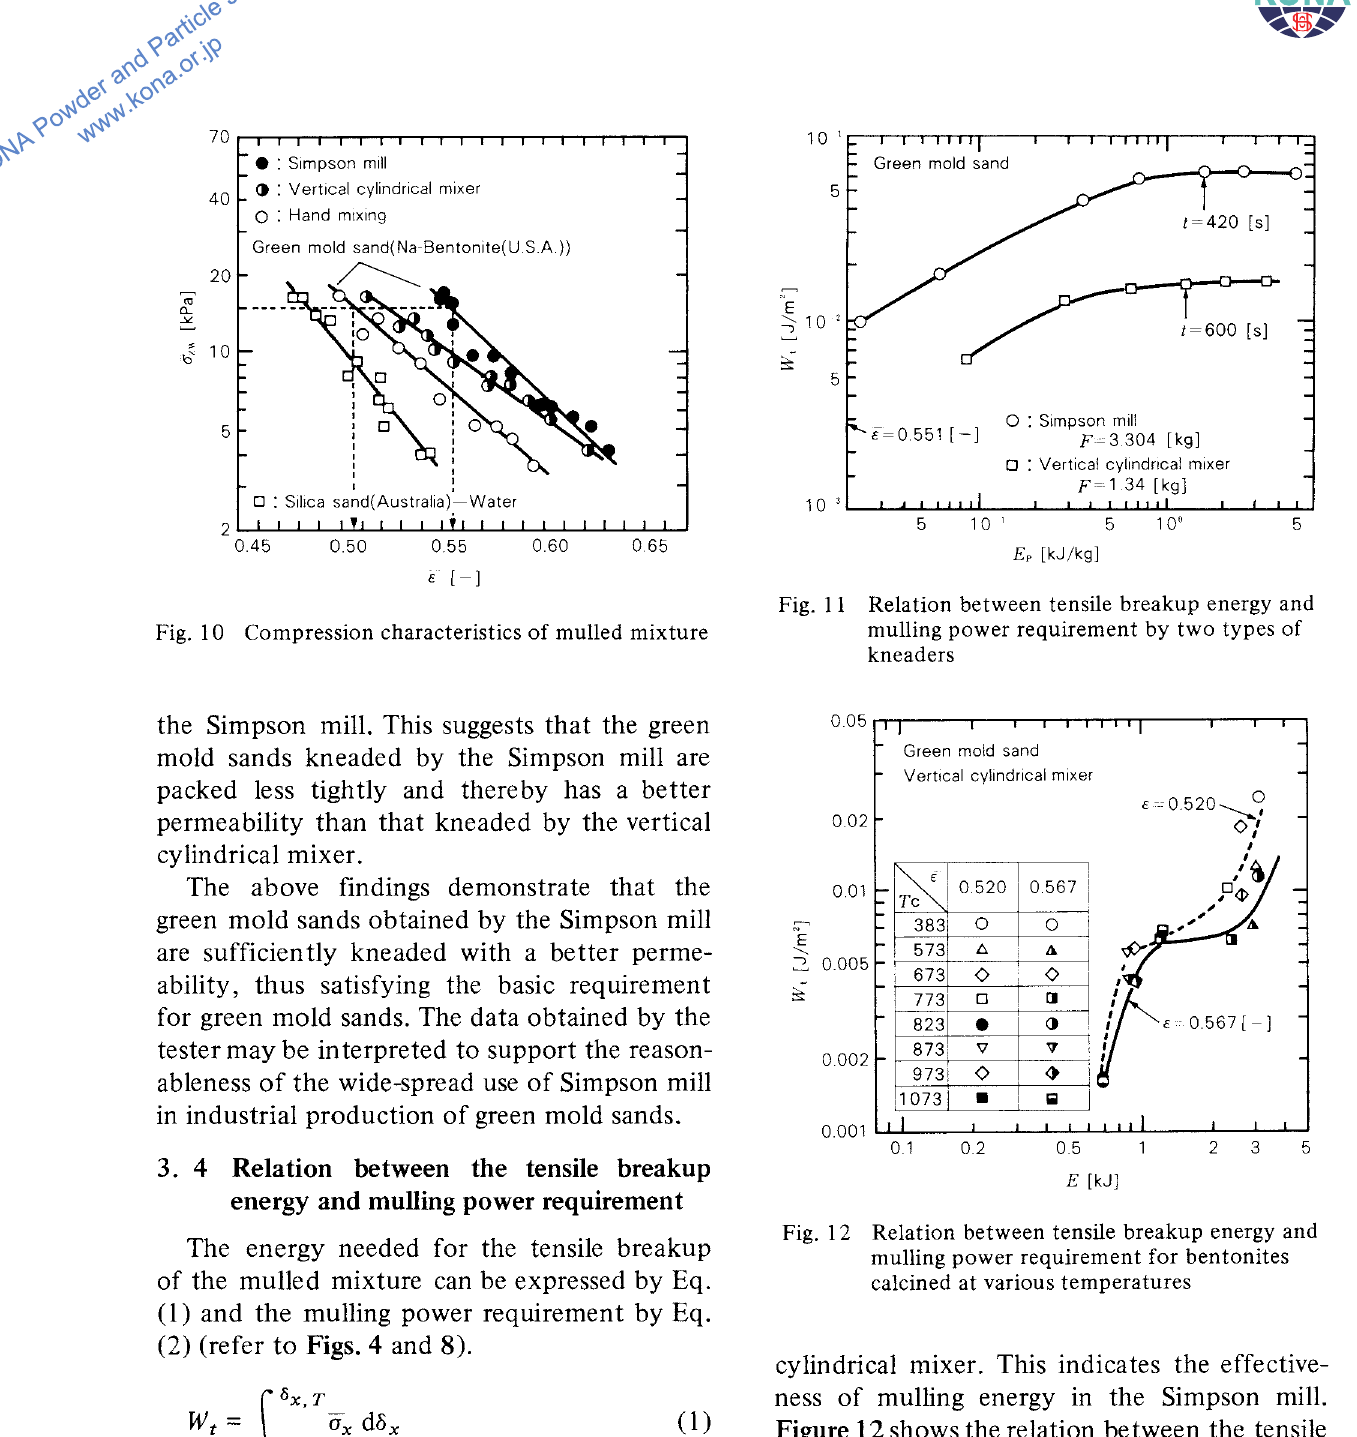
cylindrical mixer. This indicates the effective ness of mulling energy in the Simpson